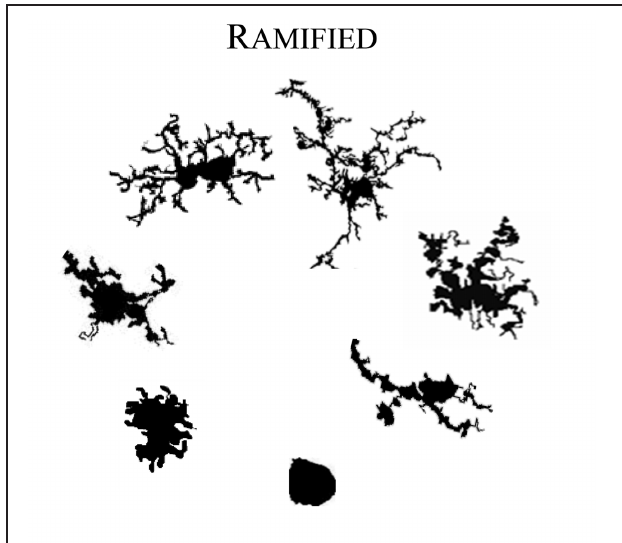
FIGURE 1 | Microglial morphology in adult human CNS. Microglia are morphologically and functionally dynamic cells able to change form from highly ramified to completely lacking processes. The transition can be very rapid or microglia can remain in a form for years (Colton et al., 2000). The forms illustrated here represent snapshots of a transformation that is reversible at every point, with variation within each form shown. The figures are not shown to scale; they are adjusted to compare